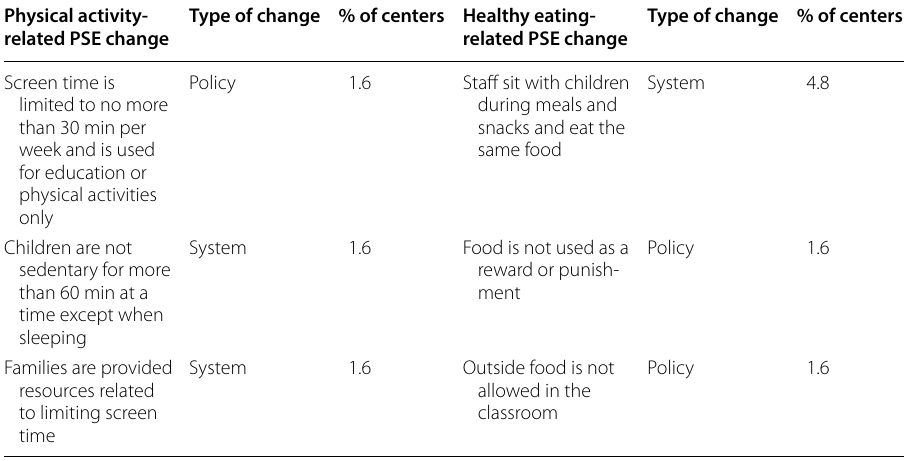
Table 4 Implementation and sustainability of PSE changes by ECE center setting